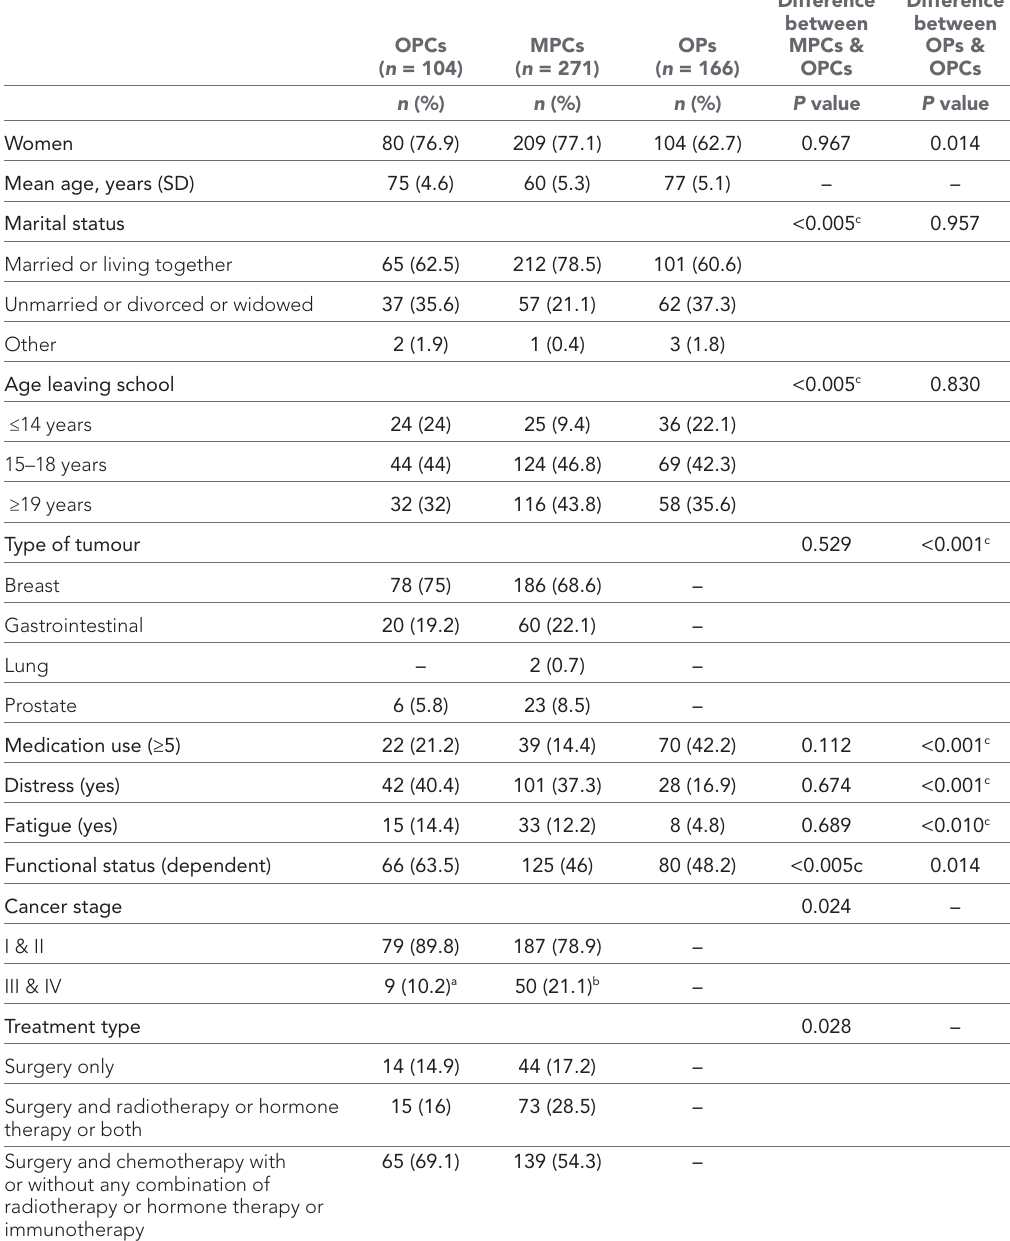
Table 1 Baseline characteristics of final study population ( n = 541)